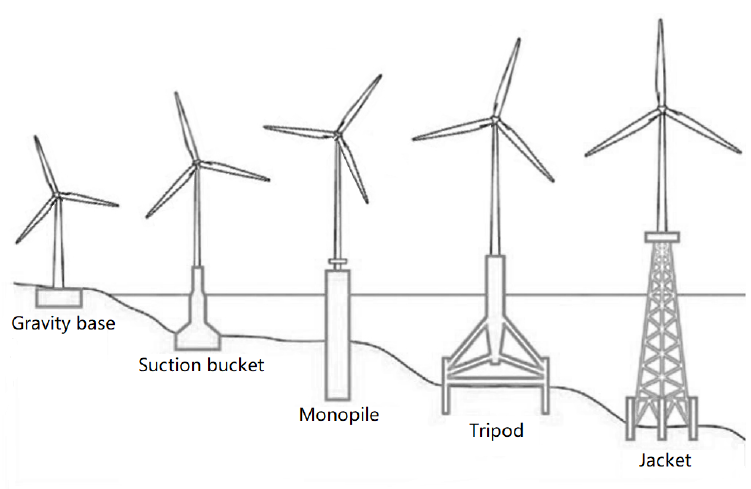
Figure 1. The major types of offshore wind turbine foundation (after